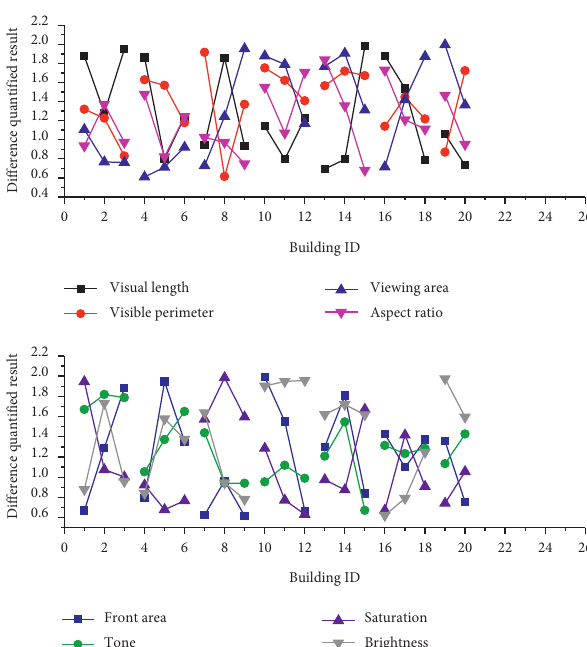
Figure 2: Differentiated metrics of building attributes.